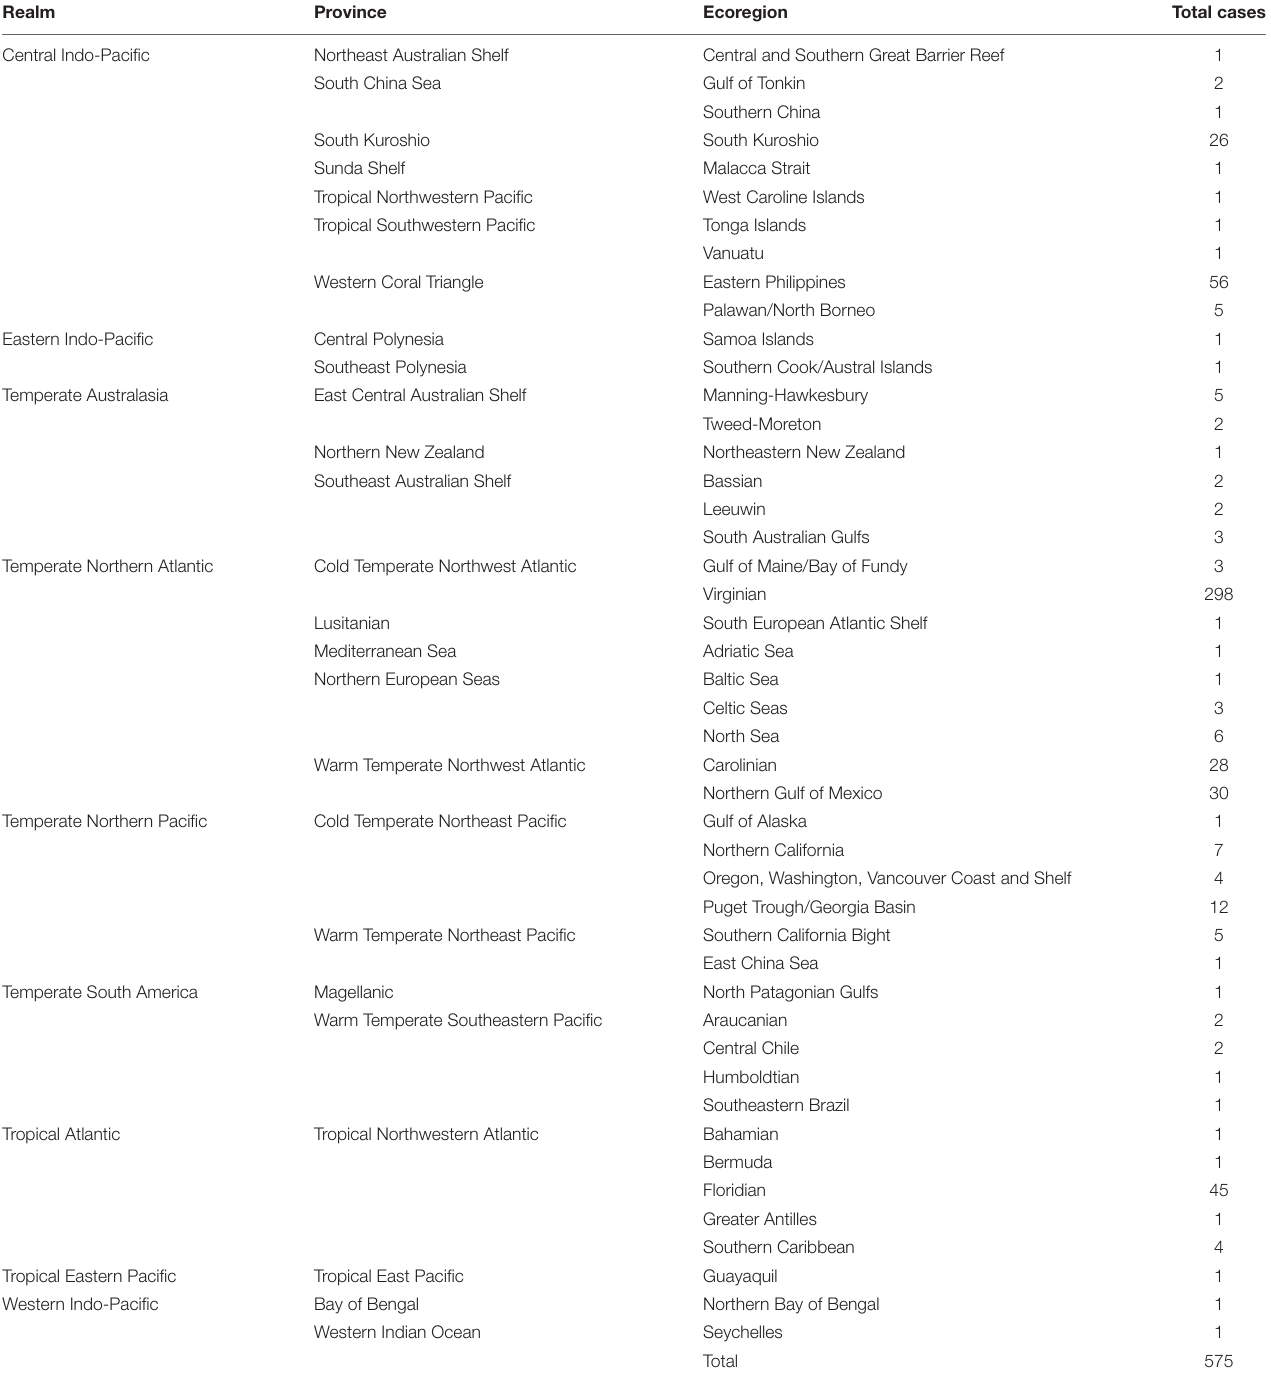
TABLE 2 | Number of Restorative Shellfish Mariculture (RSM) projects here analyzed, by realm, province, and ecorregion.